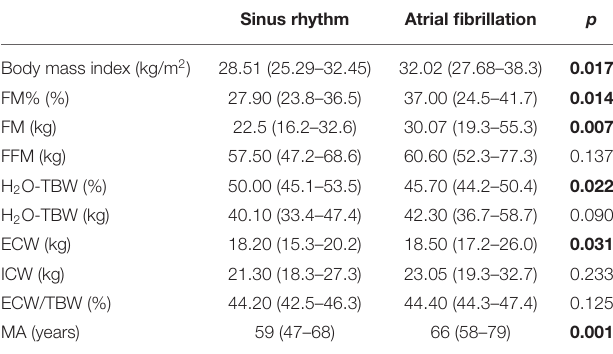
TABLE 5 | Comparison between body mass analysis variables in AF and non-AF groups. Sinus rhythm Atrial fibrillation